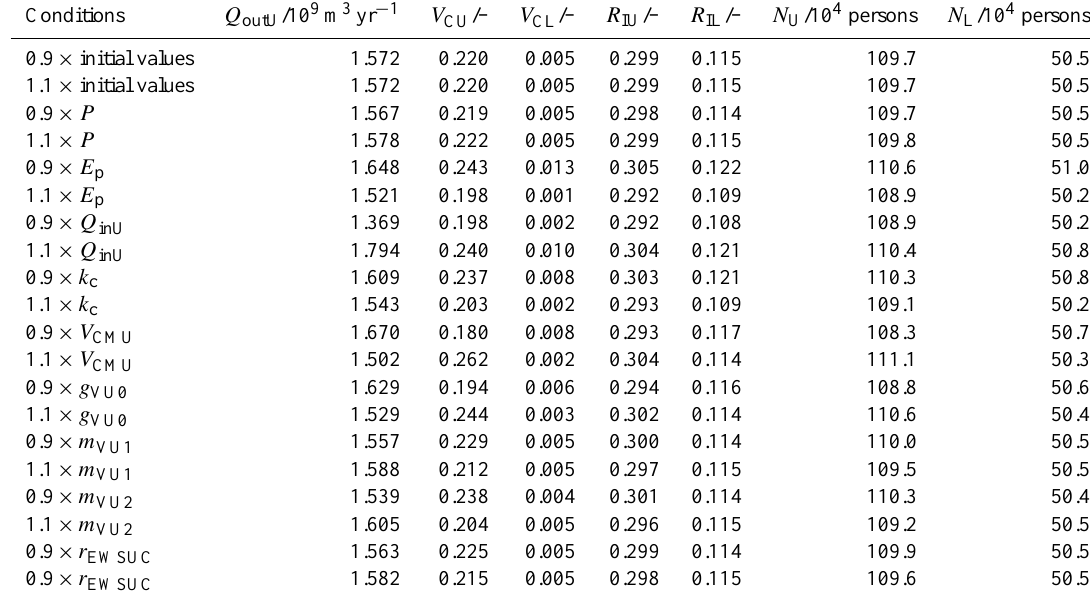
Table 4. Mean values of state variables during the last 60 years of system evolution for sensitivity tests. Conditions